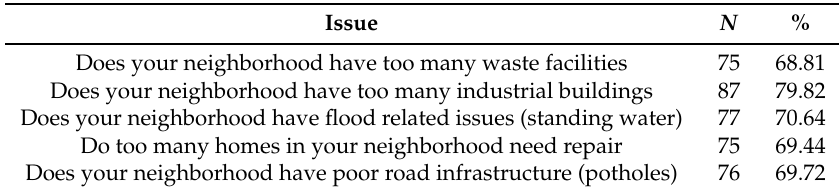
Table 2. Total number and percent of identified problems through surveying in the neighborhood of Manchester in Houston, TX in 2015 by issue.